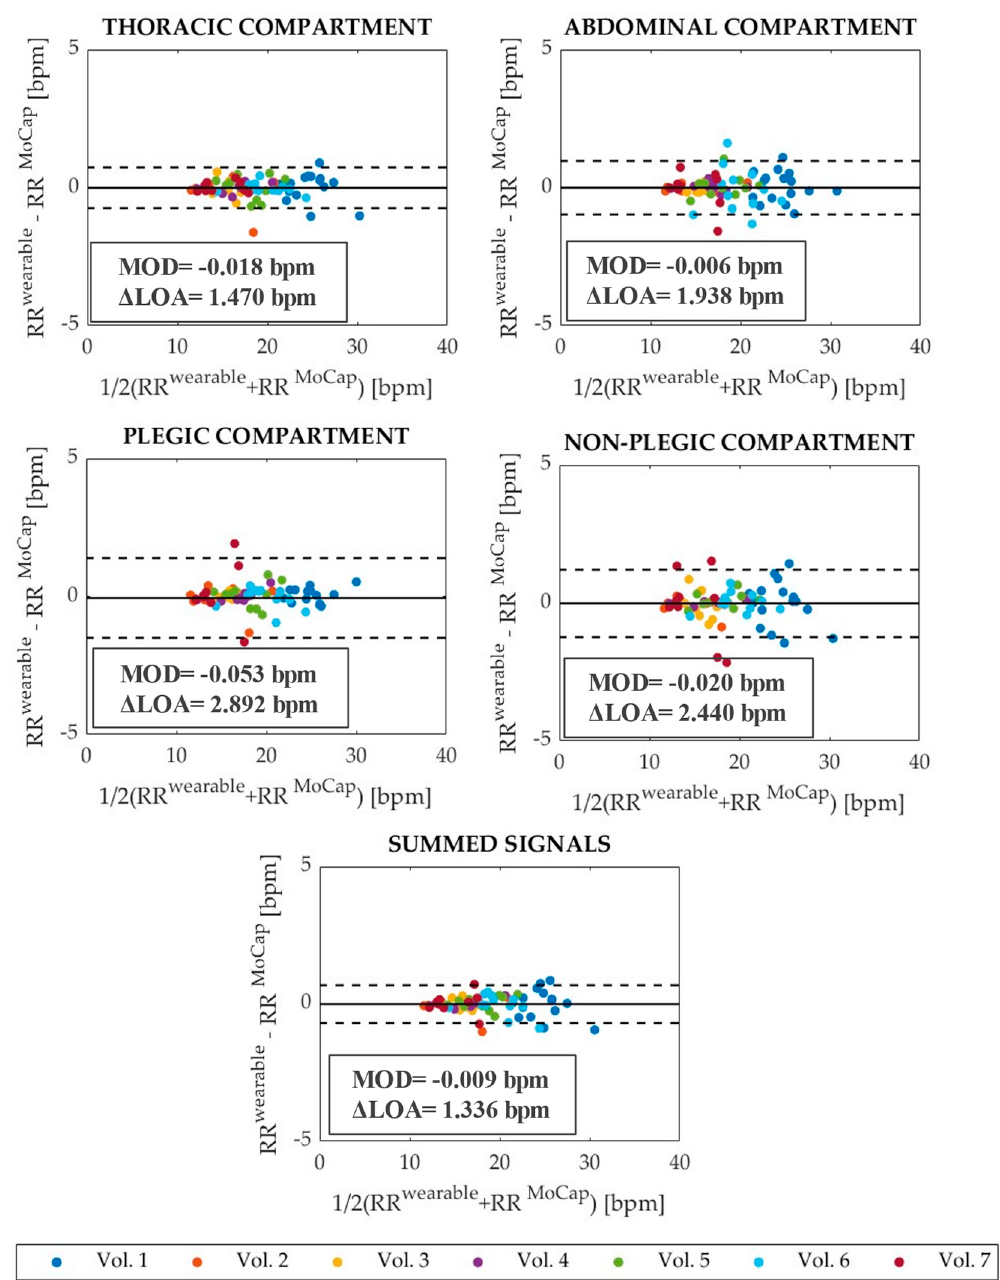
Figure 3. Bland–Altman plots showing the bias between RR wearable and RR MoCap calculated from the thoracic, abdominal, plegic, and non-plegic compartments’ data and the summed signals retrieved during the eupnea trials (Trials 1). The MOD and Δ LOA are reported on each graph. In addition, MOD is represented with black solid lines, while Δ LOA is the span comprised between the two black dotted lines.